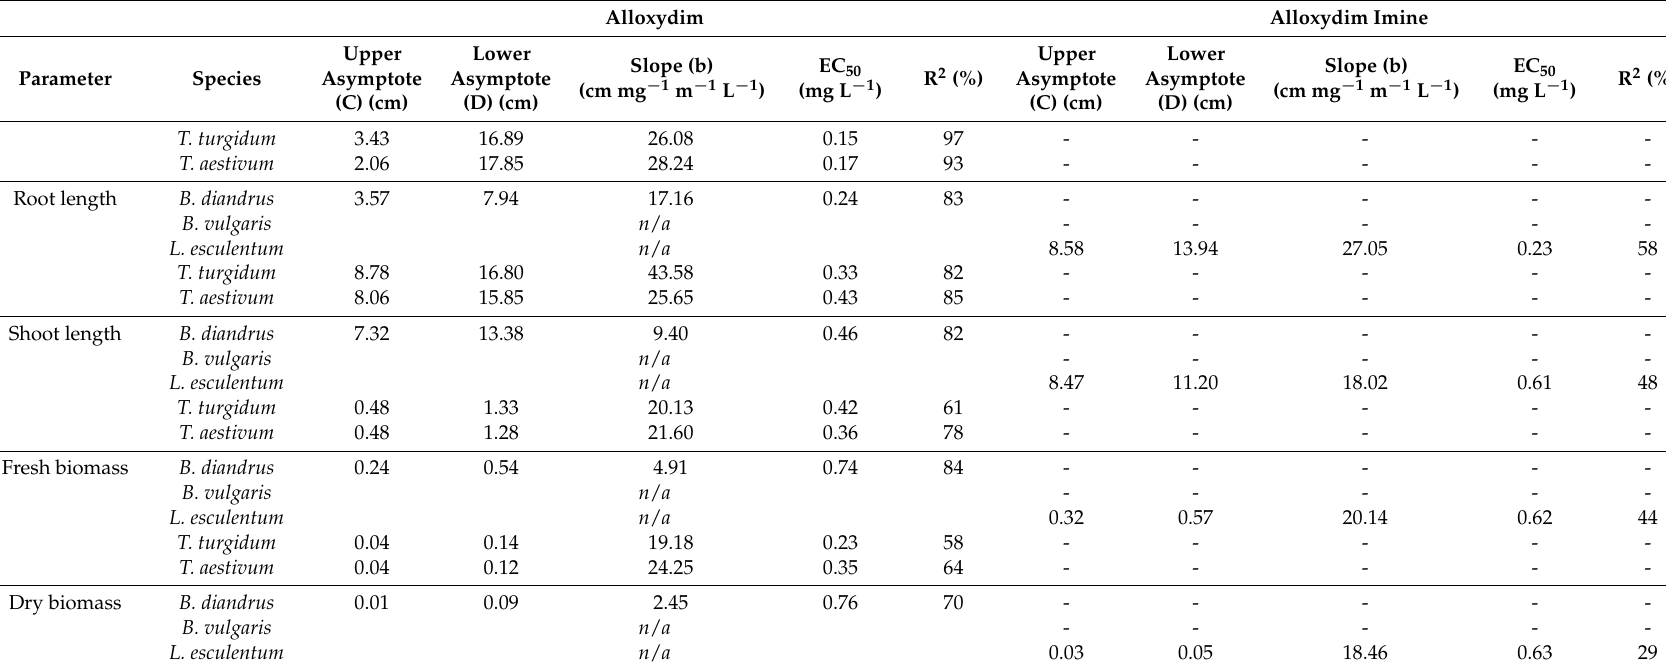
Table 1. Regression equation (by Seefeldt equation) and EC 50 values for alloxydim and the alloxydim imine tested in bioassay parameters that were the object of study †